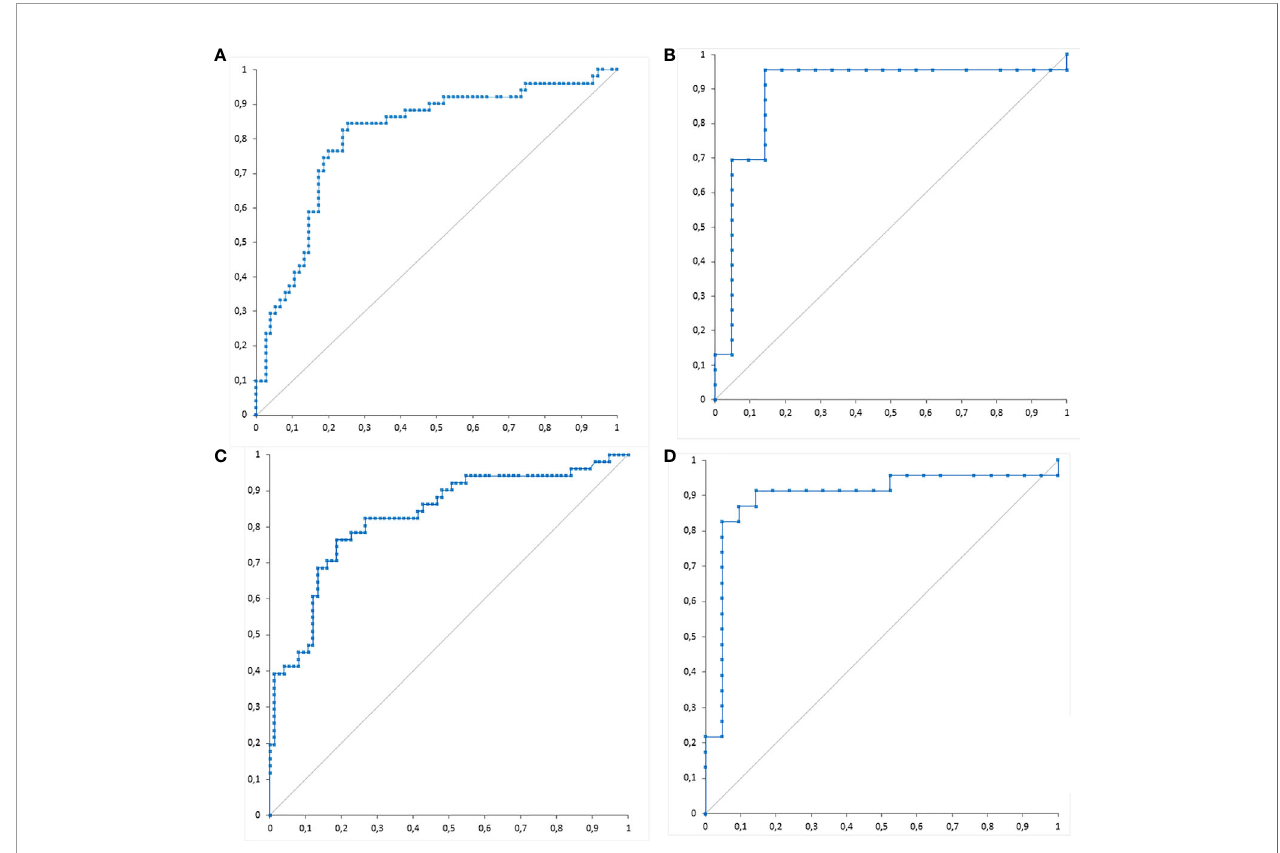
FIGURE 2 | Receiver operating characteristic (ROC) curves of VIDAS ® GM for (A) total serum samples and (B) serum samples collected 15 days before or after the date of invasive aspergillosis diagnosis. ROC curves of Platelia ™ Aspergillus Ag for (C) total serum samples and (D) serum samples collected 15 days before or after the date of invasive aspergillosis